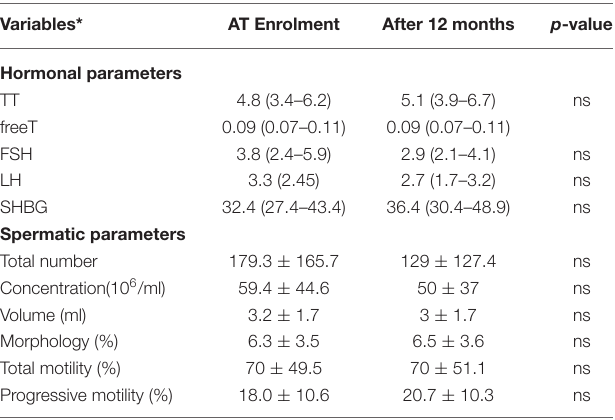
Table 5 | Association between androgen levels and longitudinal changes in clinical and radiological outcomes. Longitudinal changes Hormone